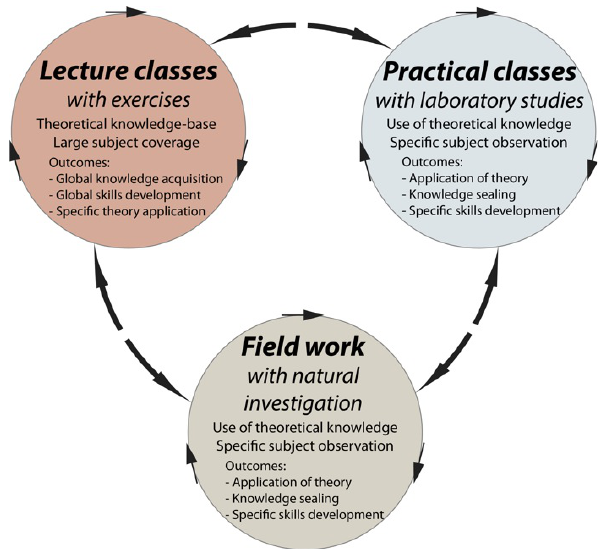
Fig. 1. Our interpretation of an integrated hydrogeology pedagogy associated to an iterative loop over three class components. Within an iterative loop, each component support the others with mutual feedback. Inspired from Gleeson et al. (2012).